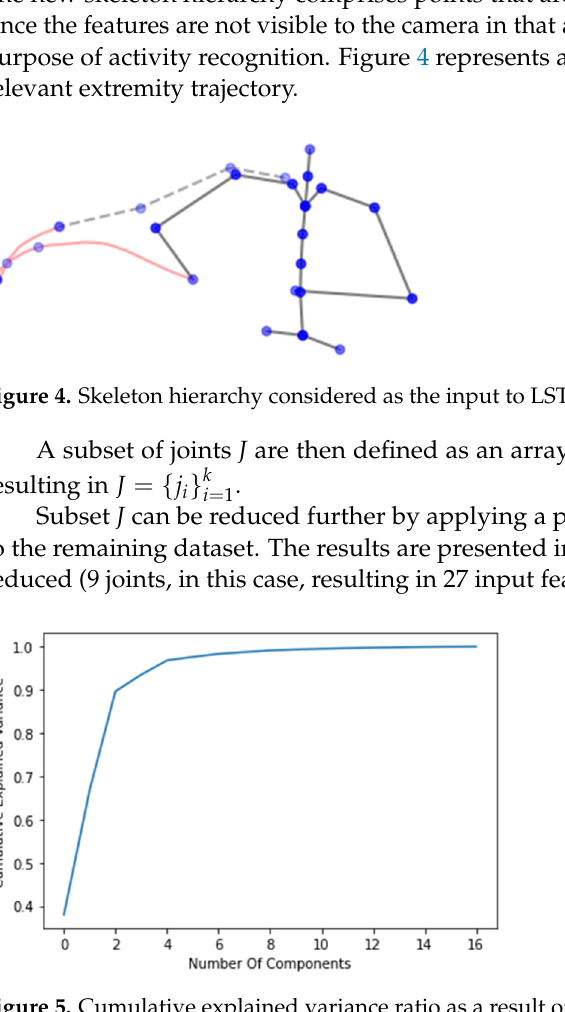
Figure 5. Cumulative explained variance ratio as a result of the PCA.